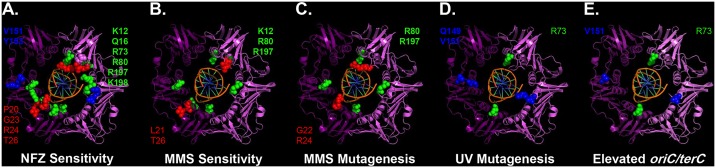
Summary of the major phenotypes observed for dnaN mutations.Residues that played a significant role in protecting E. coli against killing by (A) NFZ or (B) MMS, or that when substituted significantly affected (C) the frequency of mutagenesis induced by exposure to MMS, (D) the frequency of mutagenesis induced by exposure to UV light, or (E) the ratio of oriC to terC, suggesting an hda defect, are represented on the structure of the β clamp-DNA complex. Residues are color coded by position, with those in loop I colored red, loop II colored blue, and the central pore colored green. This image was generated using the MacPyMol Molecular Graphics System, Ver. 1.7.4 Schrodinger, LLC and the coordinates for the crystal structure of the β clamp-DNA complex (PBD: 3BEP).